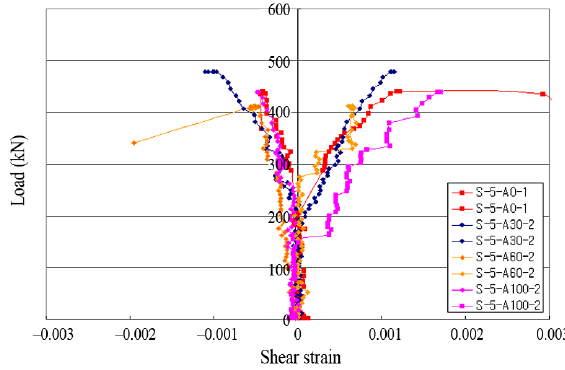
Fig. 9. Shear force versus shear strain